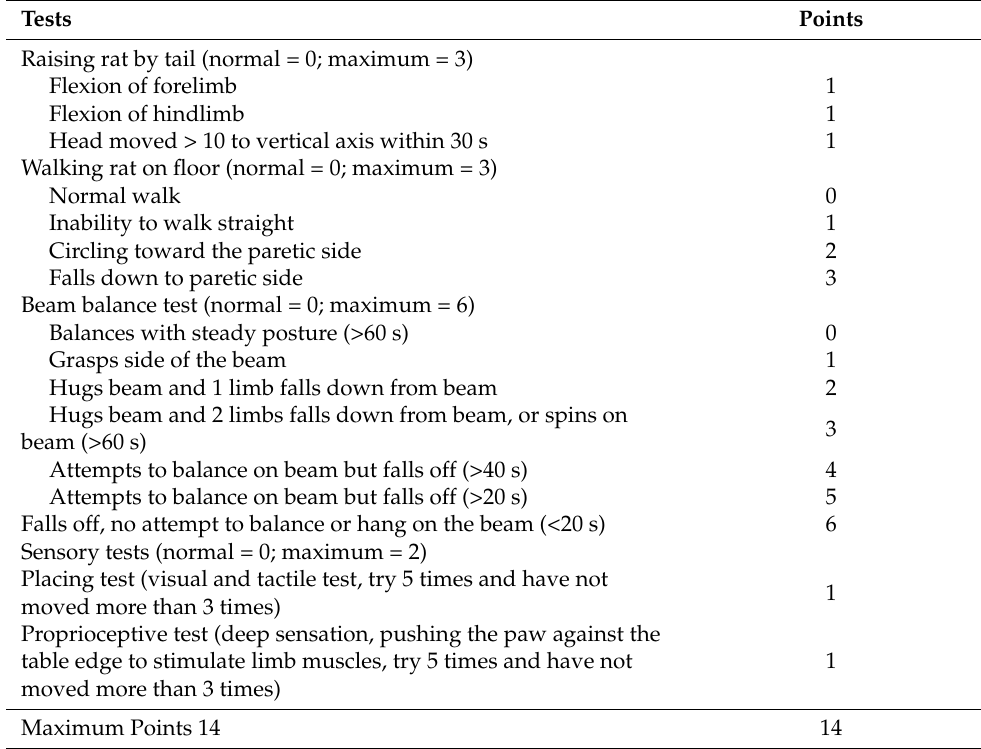
Figure 8. Schematic timeline for assessment of the effects of hUCB and rhEPO in ameliorating mouse brain lesions and behavioral outcomes. Postnatal day 7 (P7) mice were induced with a hypoxic–ischemic brain injury. On P14, the hUCB (3 × 10 7 /kg) was injected, administered via intraperitoneal injection, and rhEPO (500 IU/kg) was given intraperitoneally from the beginning on P14 for five consecutive days (white arrows). MK-2206 (100 mg/kg) was given intraperitoneally from the beginning on P14 for five consecutive days from 1 h before hUCB and rhEPO treatment. One week after injection, the mice were sacrificed for qRT-PCR and Western blot (red arrows). For long-term follow-up, the mice were assessed for behavioral test and histologic experiments at P42 (red arrows). Table 1. Modified neurological severity score